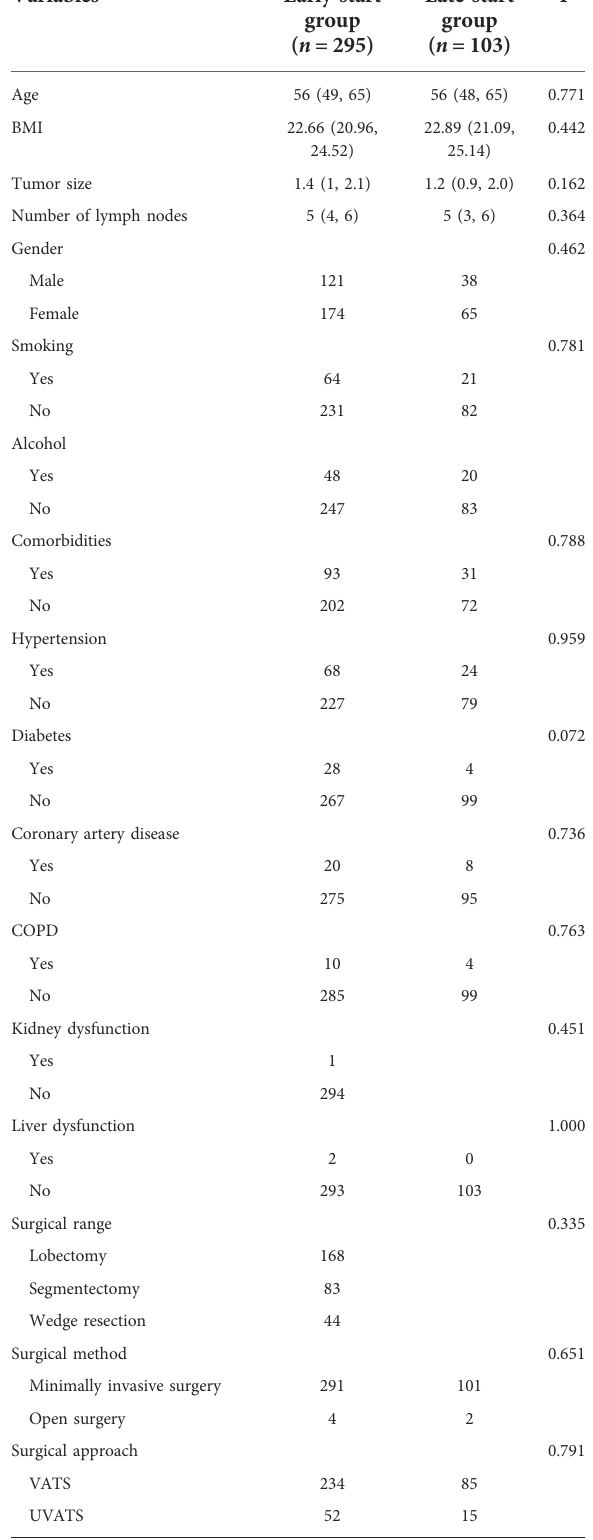
TABLE 1 Baseline characteristics comparison between the early-stage and late-stage